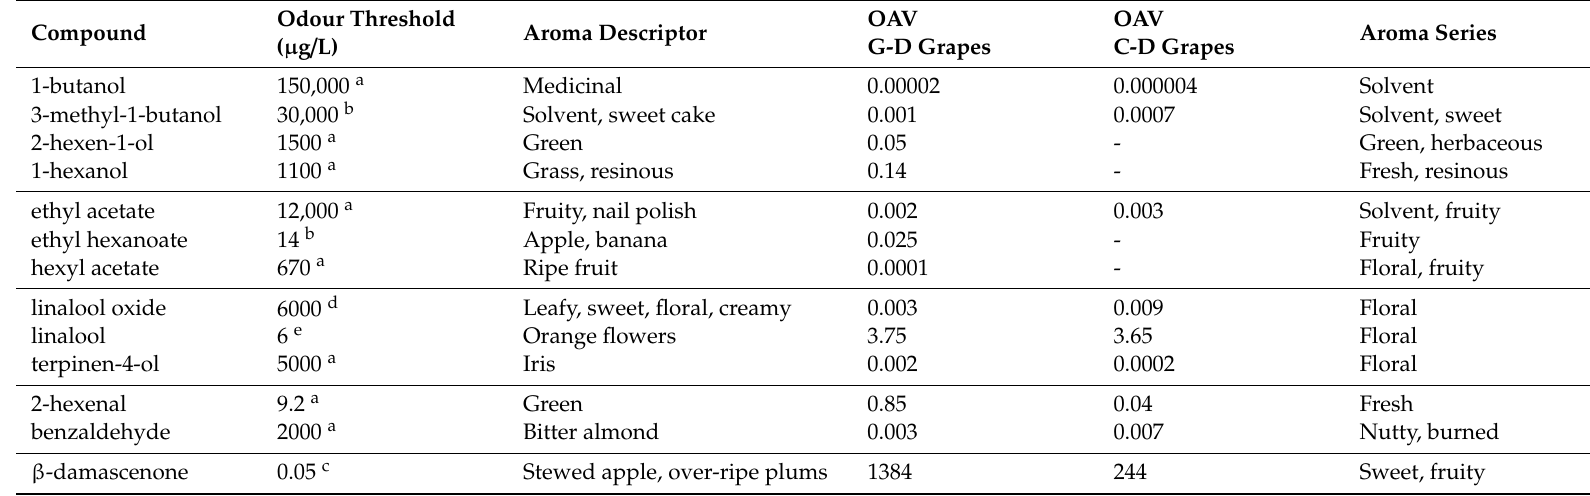
Table 4. Odor threshold ( µ g / L), aroma descriptor, OAV values assigned to total free and bound key volatile aroma compounds of dried grapes, and aroma